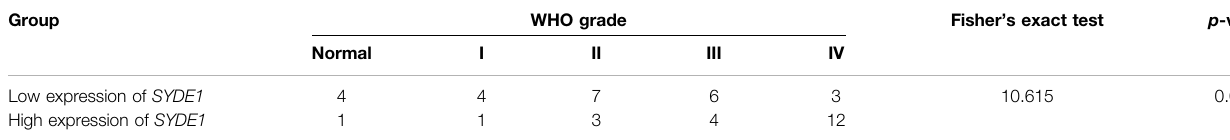
TABLE 2 | Association between SYDE1 expression and WHO grade in glioma. Group WHO grade